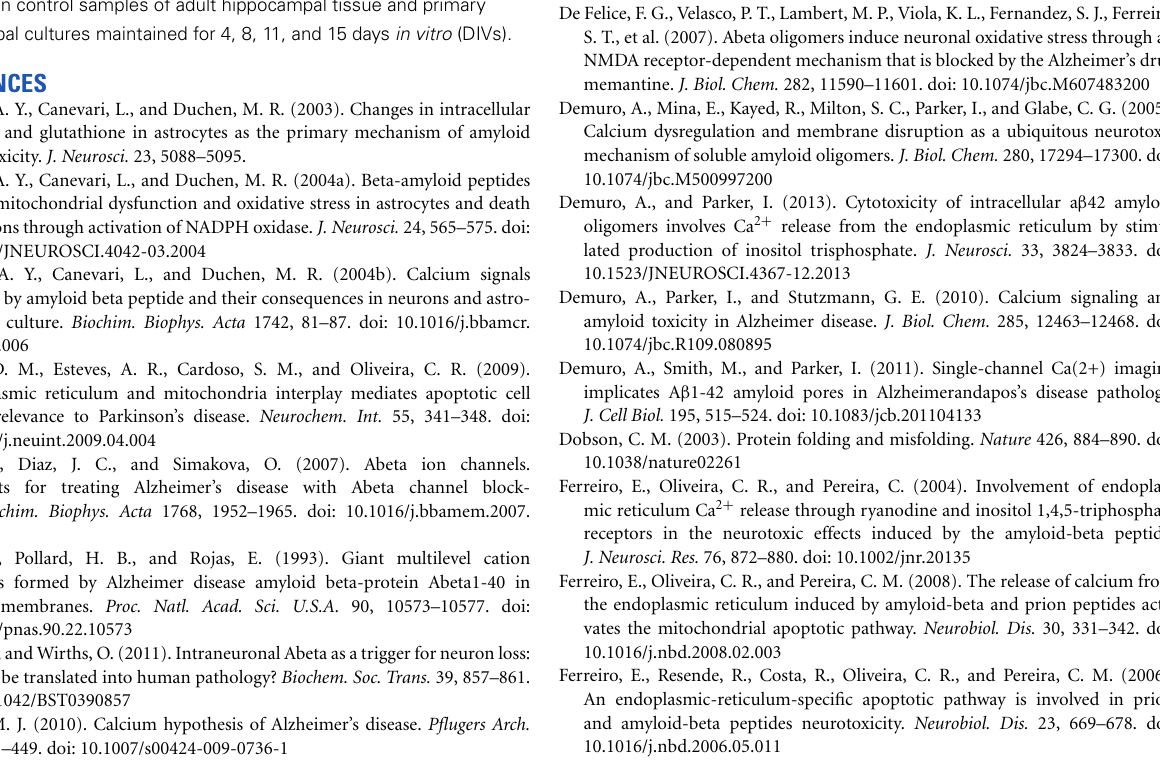
Figure S3 | Human neuroblastoma SH-SY5Y cells lack RyR expression.